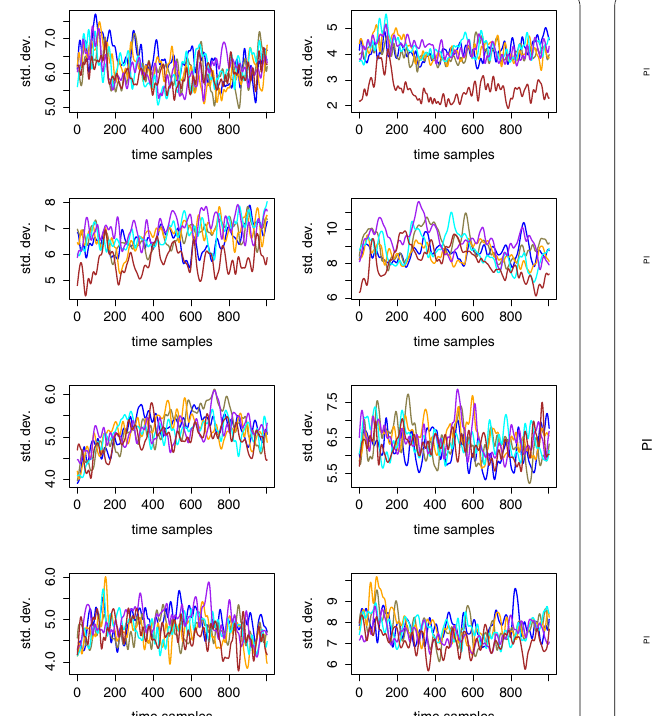
Fig. 16 Standard deviation traces for different tag values corresponding to Users 1, 3, 5 and 7 (left) and Users 2, 4, 6 and 8 (right), Electrode P8